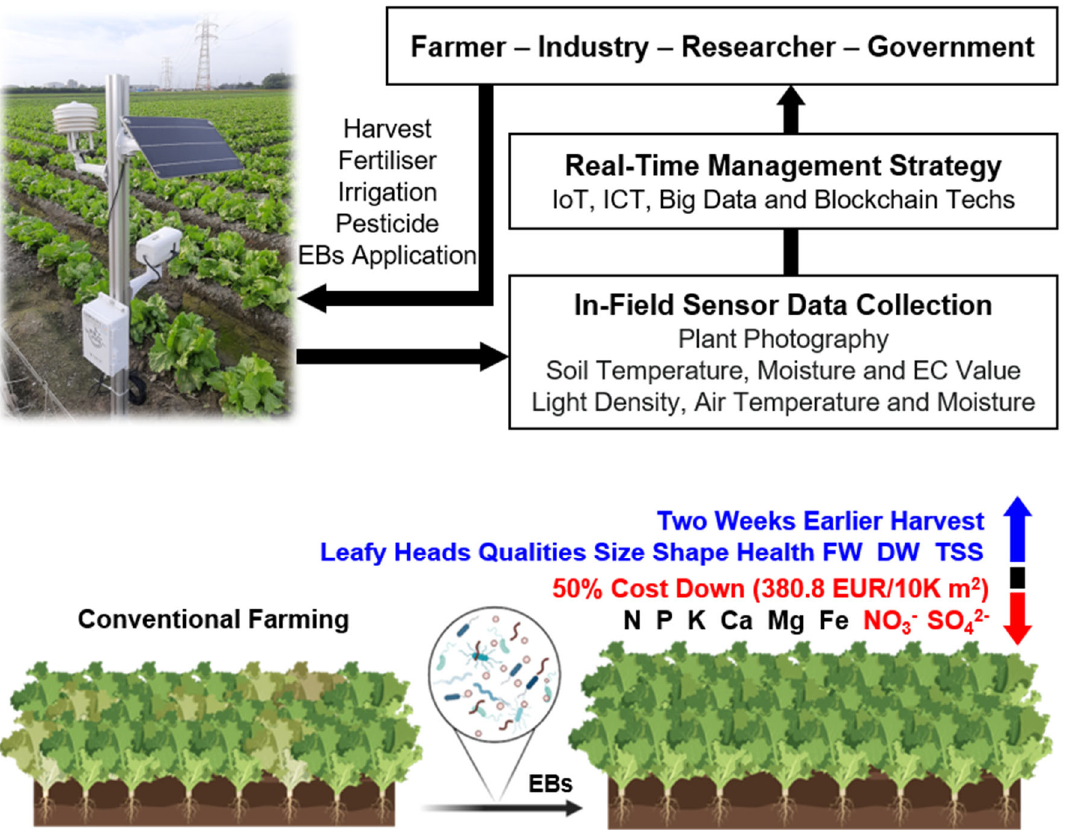
Figure 5. A schematic diagram proposed to illustrate the endophytic biostimulant-assisted integrated lettuce production system in Taiwan. EBs, endophytic biostimulants; IoT, Internet of Things; ICT, information and communications technology; EC, electrical conductivity; FW, fresh weight; DW, dry weight; TSS, total soluble sugar. Icons were created with BioRender.com.